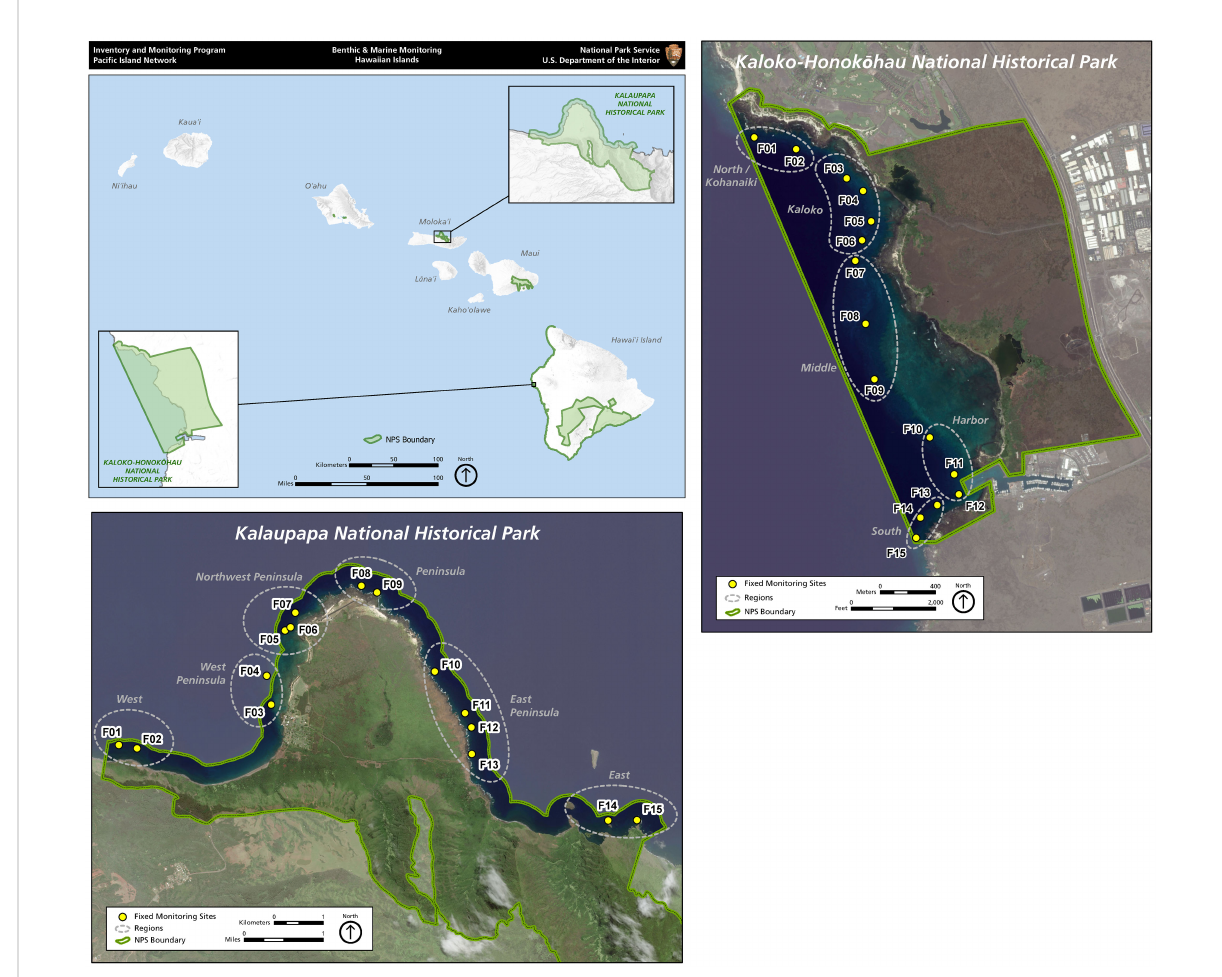
FIGURE 1 Map of the main Hawaiian Islands, showing the locations of the two national parks and permanent survey sites within each